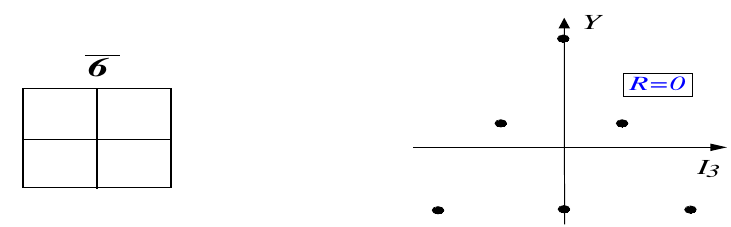
Figure 7. Young tableaux and flavor content of the anti-sextet